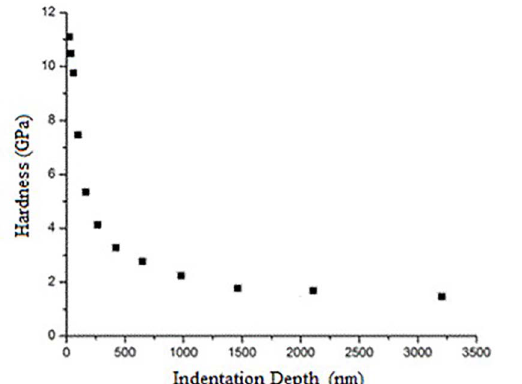
Figure 3. Experimental results for instrumented Vickers hardness as a function of h for the Ti/TiN system. max